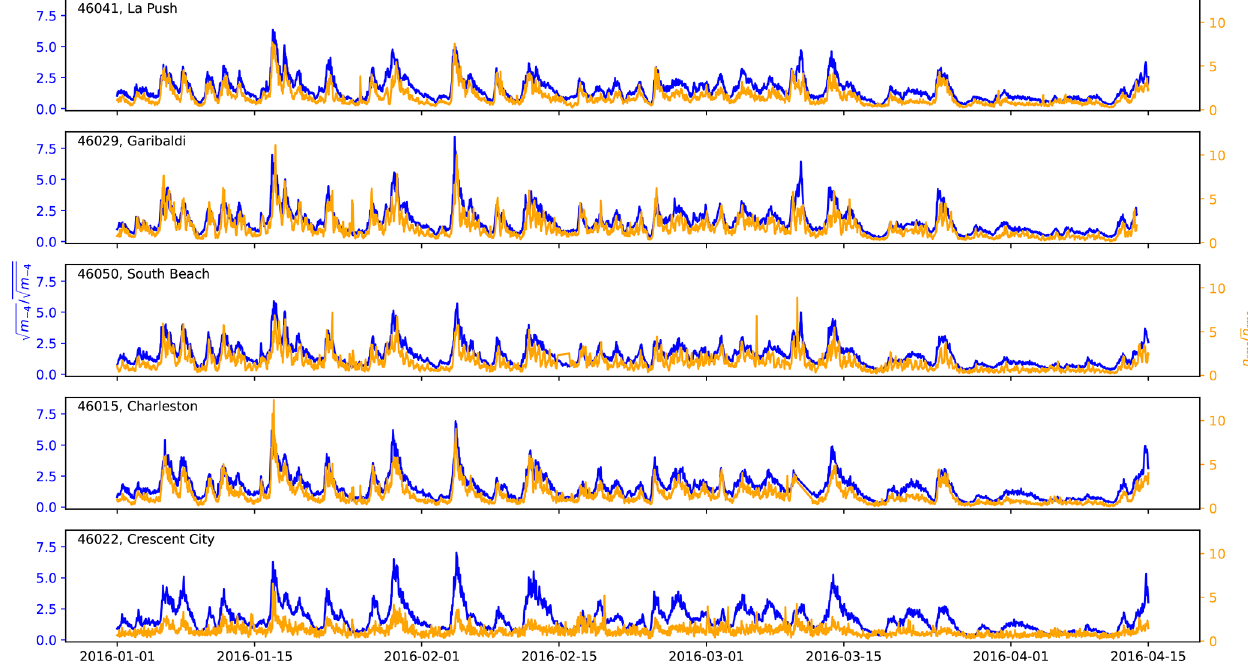
√ √ m − 4 / m − 4 (blue) of the offshore ocean wave spectra and η rms /η rms (orange) at the onshore tide gages, computed using a Figure 14. 0.5h window, from 1 January to 15 April 2016. The date format on the x axis is year-month-day.